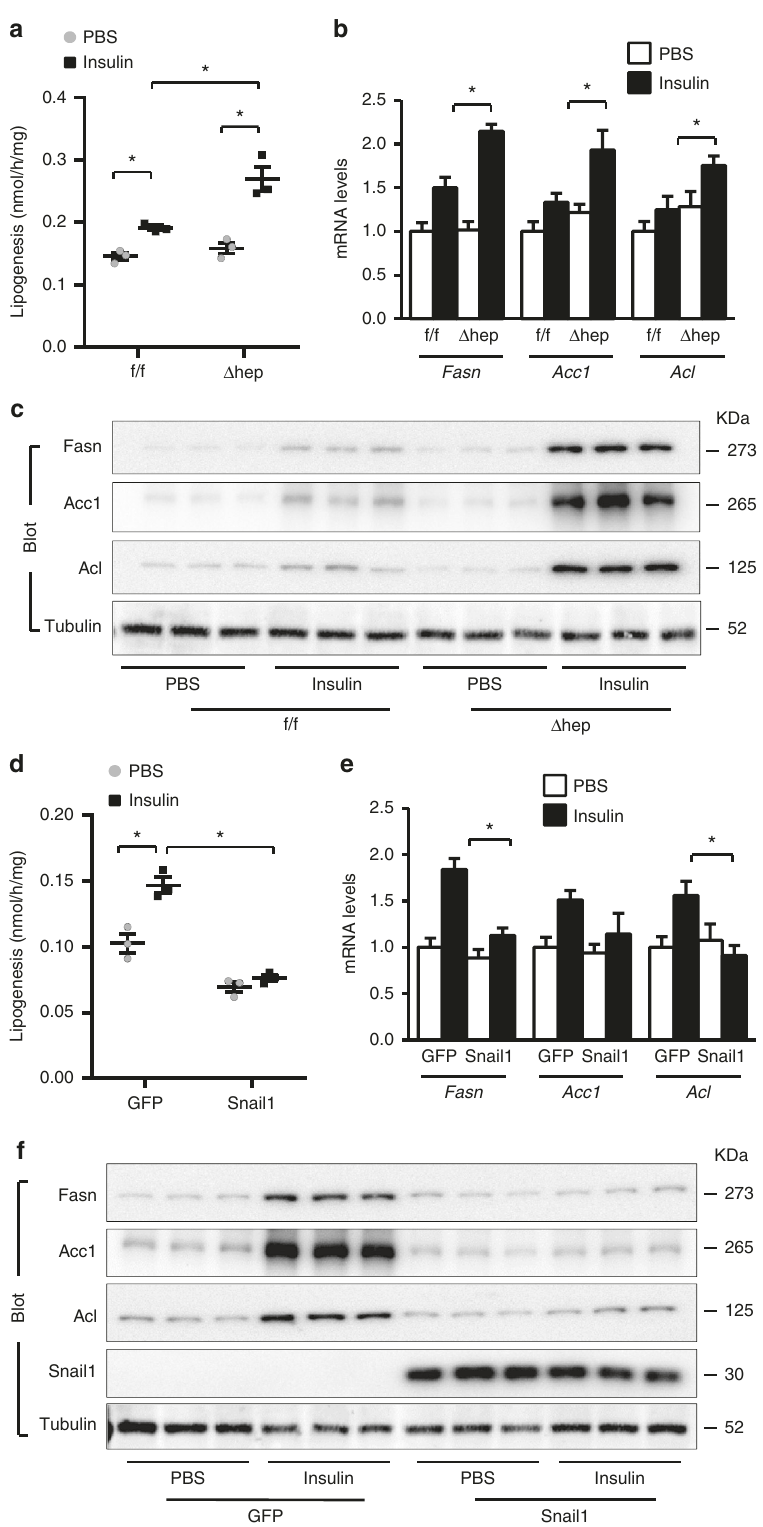
Fig. 2 Insulin/Snail1 axis suppresses de novo lipogenesis in hepatocytes. a – c Primary hepatocytes were isolated from Snail1 Δ hep and Snail1 fl ox/ fl ox littermates and stimulated with insulin (50 nM) or PBS for 12 h ( a , c ) or 4 h ( b ). a De novo lipogenesis assays (normalized to protein levels; n = 3). b Fasn , Acc1 , and Acl mRNA levels (normalized to 36B4 levels; n = 4). c Cell extracts were immunoblotted with the indicated antibodies. d – f Primary hepatocytes were transduced with Snail1 or GFP adenoviral vectors and stimulated with insulin (50 nM) for 12 h ( d , f ) or 4 h ( e ). d De novo lipogenesis (normalized to protein levels; n = 3). e Fasn , Acc1 , and Acl mRNA levels (normalized to 36B4 levels; n = 4). f Cell extracts were immunoblotted with the indicated antibodies. Data are presented as mean ± SEM. * p < 0.05 by two-tailed unpaired Student ’ s t